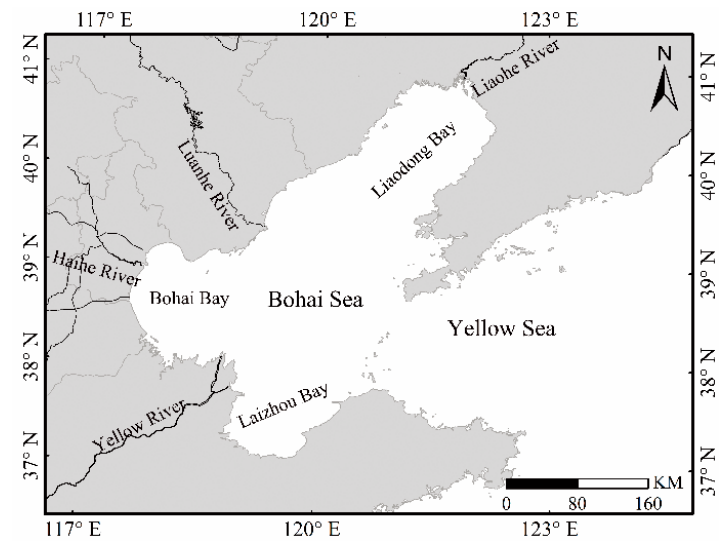
Figure 1. The study area of the Bohai Sea, including the Liaodong Bay, Bohai Bay, and Laizhou Bay.